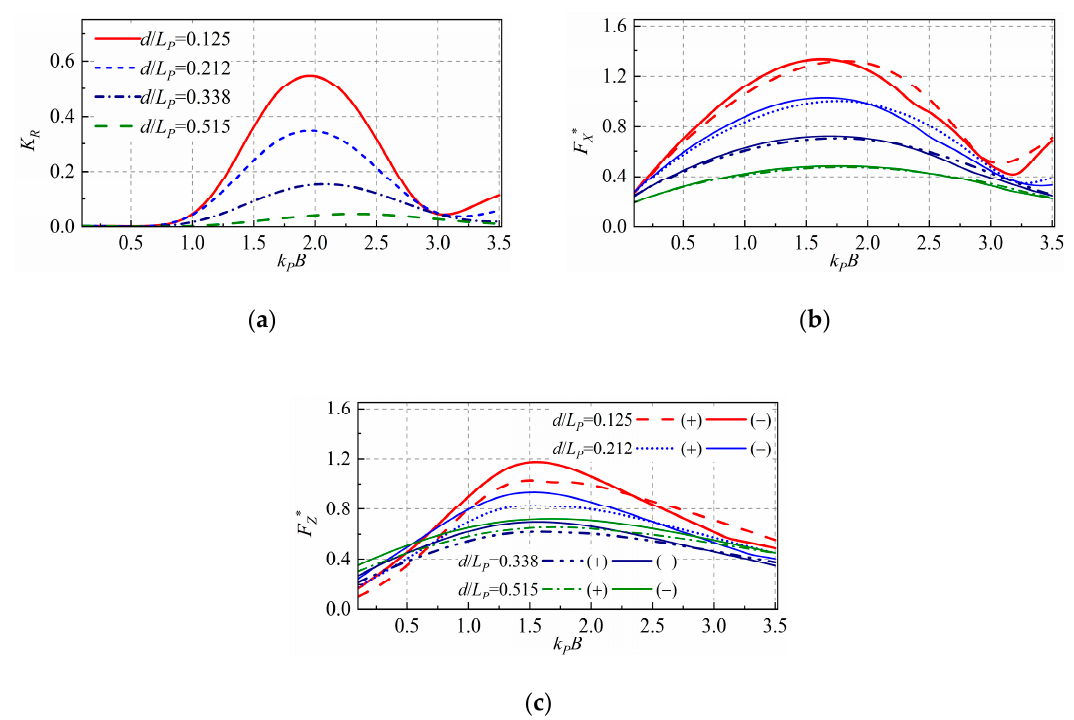
Figure 9. Variations of reflection coe ffi cients and wave forces about dimensionless breadth k P B with di ff erent peak wave length ( a ) reflection coe ffi cient, ( b ) horizontal force and ( c ) vertical force.